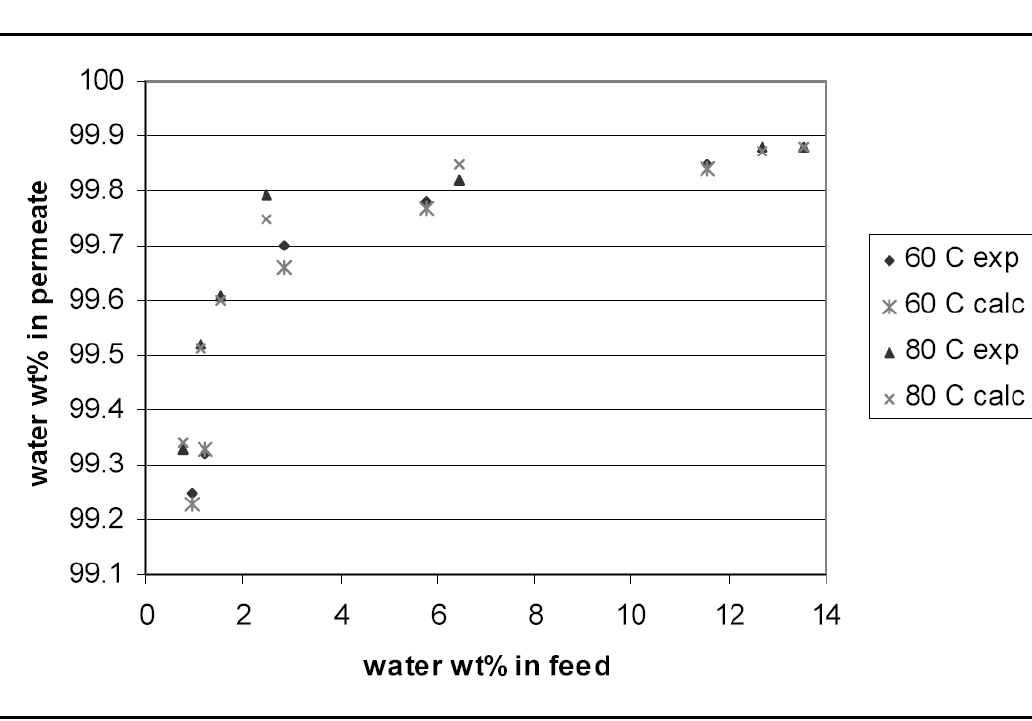
Fig. 5 Experimental and modelled permeate composition data by ethanol